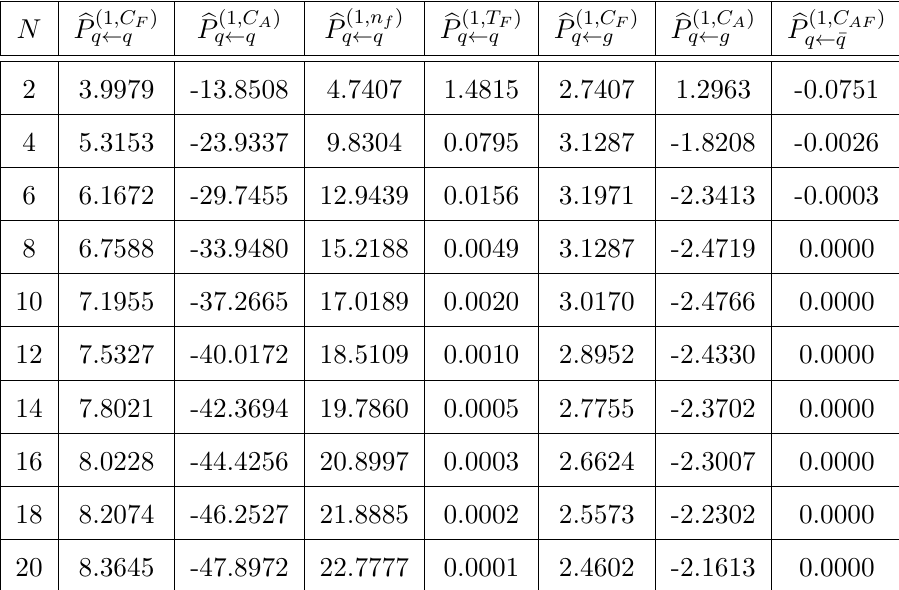
Table 1 . Two-loop splitting functions evaluated at sample values of the Mellin